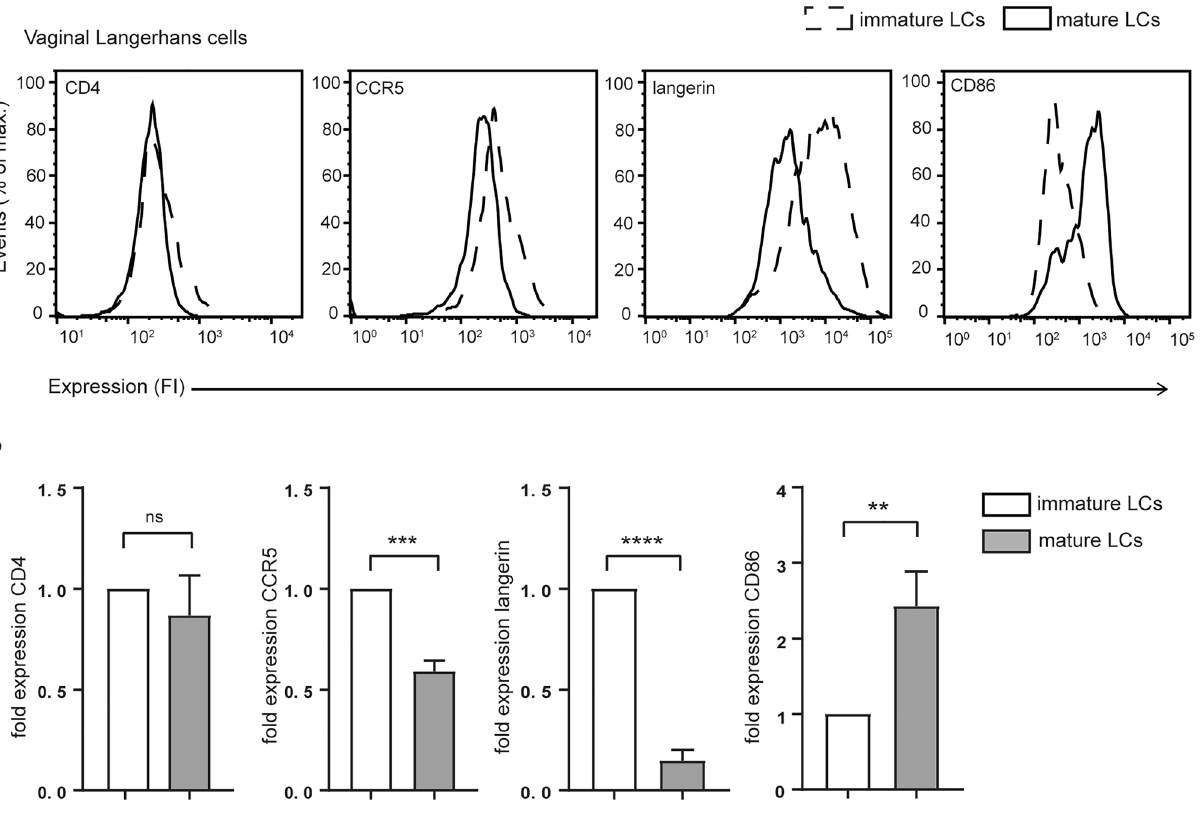
Figure 2. Immature and mature vaginal LCs diplay a differential phenotype. ( a ) representative plots of the expression of LC receptors involved in the interaction with HIV-1 (CD4, CCR5, langerin) and T cells (CD86) on immature and mature vaginal LCs as determined by flow cytometry. (( b ), N = 3) pooled data from 3 separate donors of immature and mature vaginal LCs (CD1a +) for the expression of CD4, CCR5, langerin and CD86. ** p < 0.01, *** p < 0.001, unpaired t- test, data are mean ±